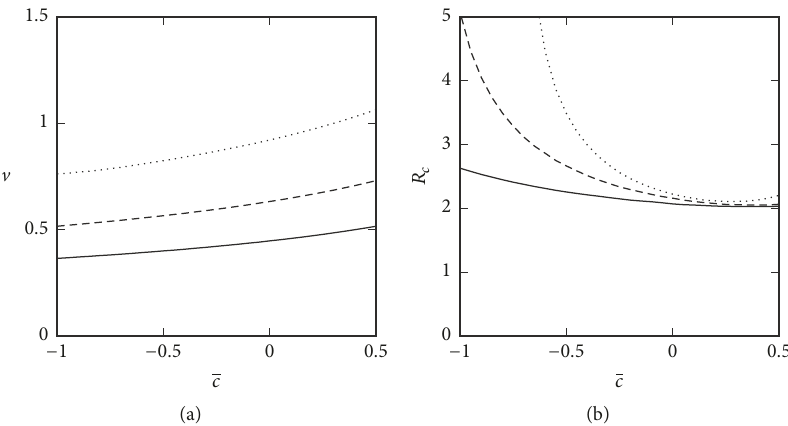
Figure 7: Dependence of velocity and radius on 𝑐 in the stationary circular motion. Data are obtained by the simulation of the reduced tensor model. 𝑏 𝑠 = 0.1 . The solid, dashed, and dotted curves correspond to (𝛾,𝜅) = (0.25, 0.1) , (0.5, 0.2) , and (1.0, 0.3) , respectively. (a) Dependence of V on 𝑐 . (b) Dependence of 𝑅 𝑐 on 𝑐